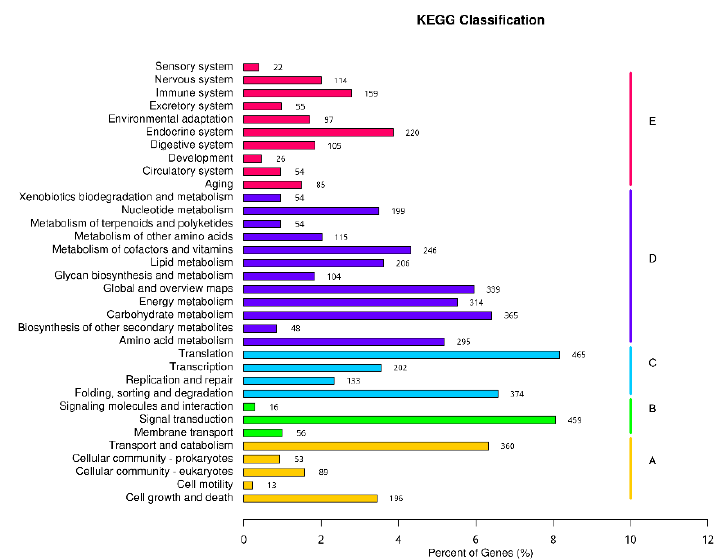
Figure 6. KEGG metabolic pathway classification statistics chart; the ordinate is the name of the KEGG metabolic pathway, and the abscissa is the number of genes annotated under the pathway and the ratio of the number to the total number of genes annotated. The genes are divided into five branches according to the KEGG metabolic pathways involved: Cellular Processes (A, Cellular Processes), Environmental Information Processing (B, Environmental Information Processing), Genetic Information Processing (C, Genetic Information Processing), Metabolism (D, Metabolism), and Organic Systems (E, Organic